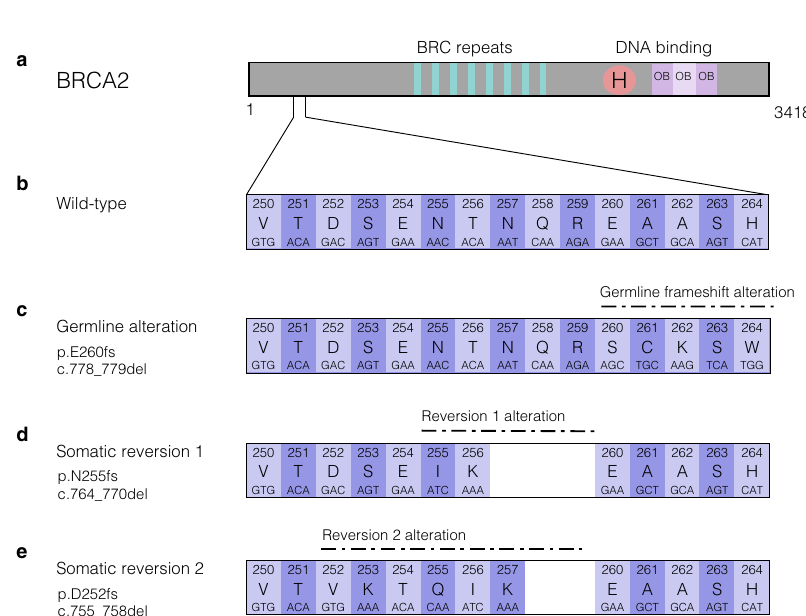
Fig. 2 Evolution of BRCA2 alterations over time. Integrative Genomics Viewer (IGV) visualization of BRCA2 sequencing data. a, b Genomic analysis of whole blood and tumor tissue from a bone metastasis reveals a 2 base pair (bp) deletion in both, indicating a germline alteration. c Genomic analysis of a metastatic liver lesion reveals both the original 2 bp deletion, as well as an additional 7 bp deletion, resulting in an in- frame somatic reversion. d, e Genomic analysis of circulating tumor DNA (ctDNA) from blood plasma shows the previously identi fi ed germline alteration and somatic reversion alteration, as well as a secondary somatic reversion mutation. Horizontal pink and blue bars are individual reads denoting forward and reverse strand sequence orientation, respectively. Gray histogram indicates relative sequencing coverage at the individual nucleotide position. A decrease in coverage is expected at the location of the deletions. Nucleotide deletions are represented as short horizontal black bars with the size of the deletion speci fi ed below the sequencing reads. Reference nucleotide sequence is indicated. Reference protein sequence at the bottom is in blue with single letter abbreviations for the amino acids and the intron depicted with a thin blue line and arrows showing directionality. The three possible open reading frames are in gray, with the third being the wild-type reading frame.